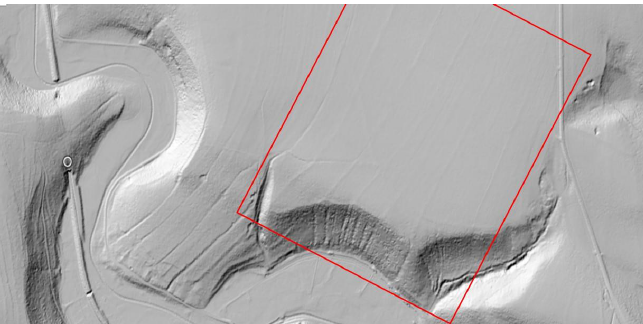
Figure 10. System of historic tracks in the DRM, ZABAGED® Height chart DMR G5 (ags.cuzk.cz, accessed on 20 July 2022); adjusted.